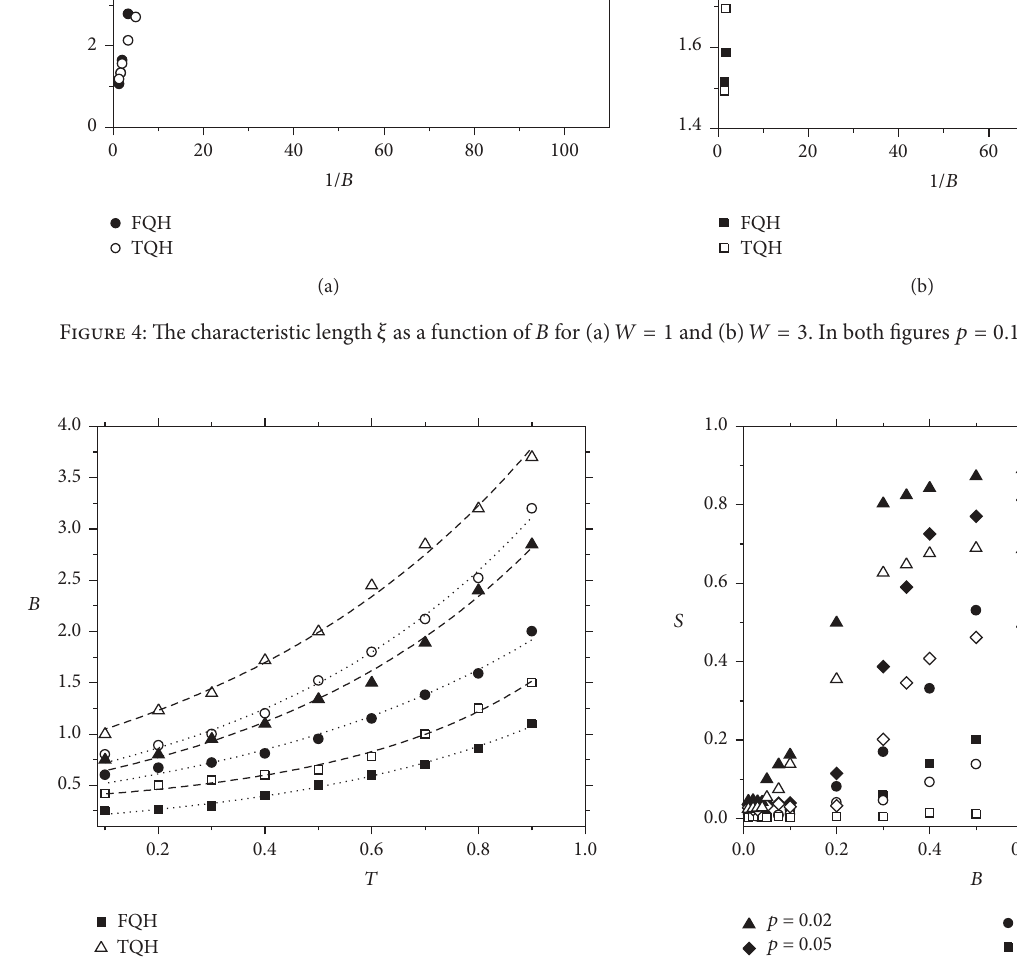
Figure 5: Regimes exhibiting different degree of ordering. Squares indicate the SRO-QLRO and triangles the QLRO-LRO transition line. Spheres indicates crossover between disorder and external field dominated regime. FQH: full symbol and TQH: empty symbols. 𝑝 = 0.1 and 𝑊 = 3 .